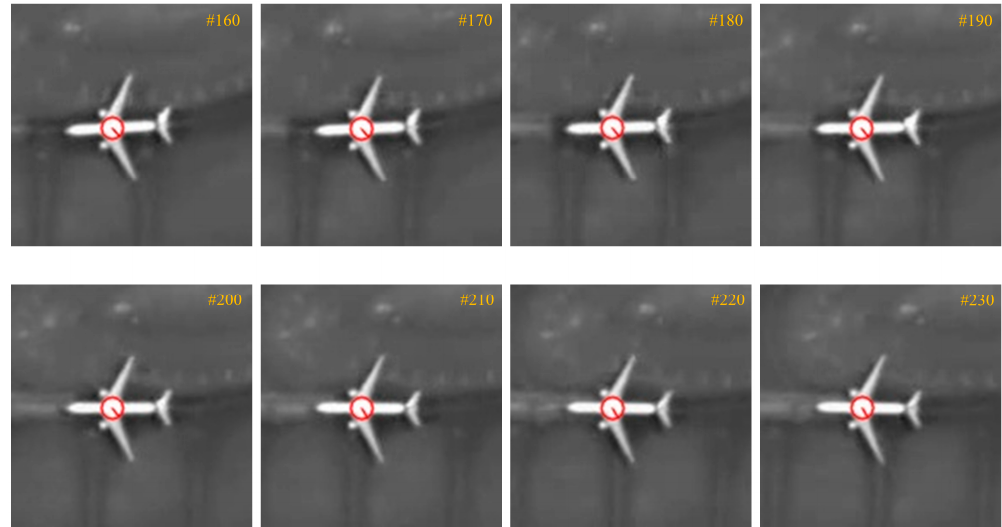
Figure 5. Extracted P-SIFT keypoint of the moving Airplane 8 shown in Figure 4. The number in each subfigure represents the frame ID in the test video.